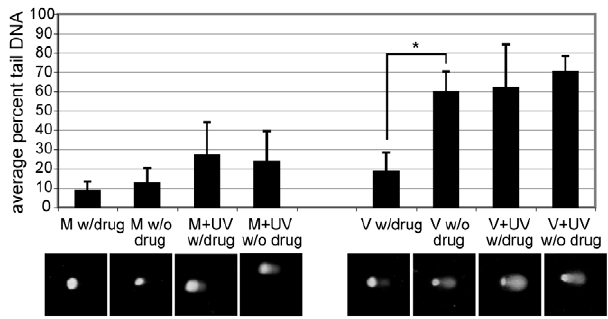
Figure 3. V alone tails were due to viral replication. Cells were treated as described in Figure 2 for comet analysis. Two parallel sets were prepared. One set received 45 m M ganciclovir continuously after 24 hpi. Cells were harvested at 24 h post irradiation for analysis. An * denotes a statistical significance of p , 0.0001 between samples as measured by unpaired t-test. Below each category is an example of the comets observed for the given